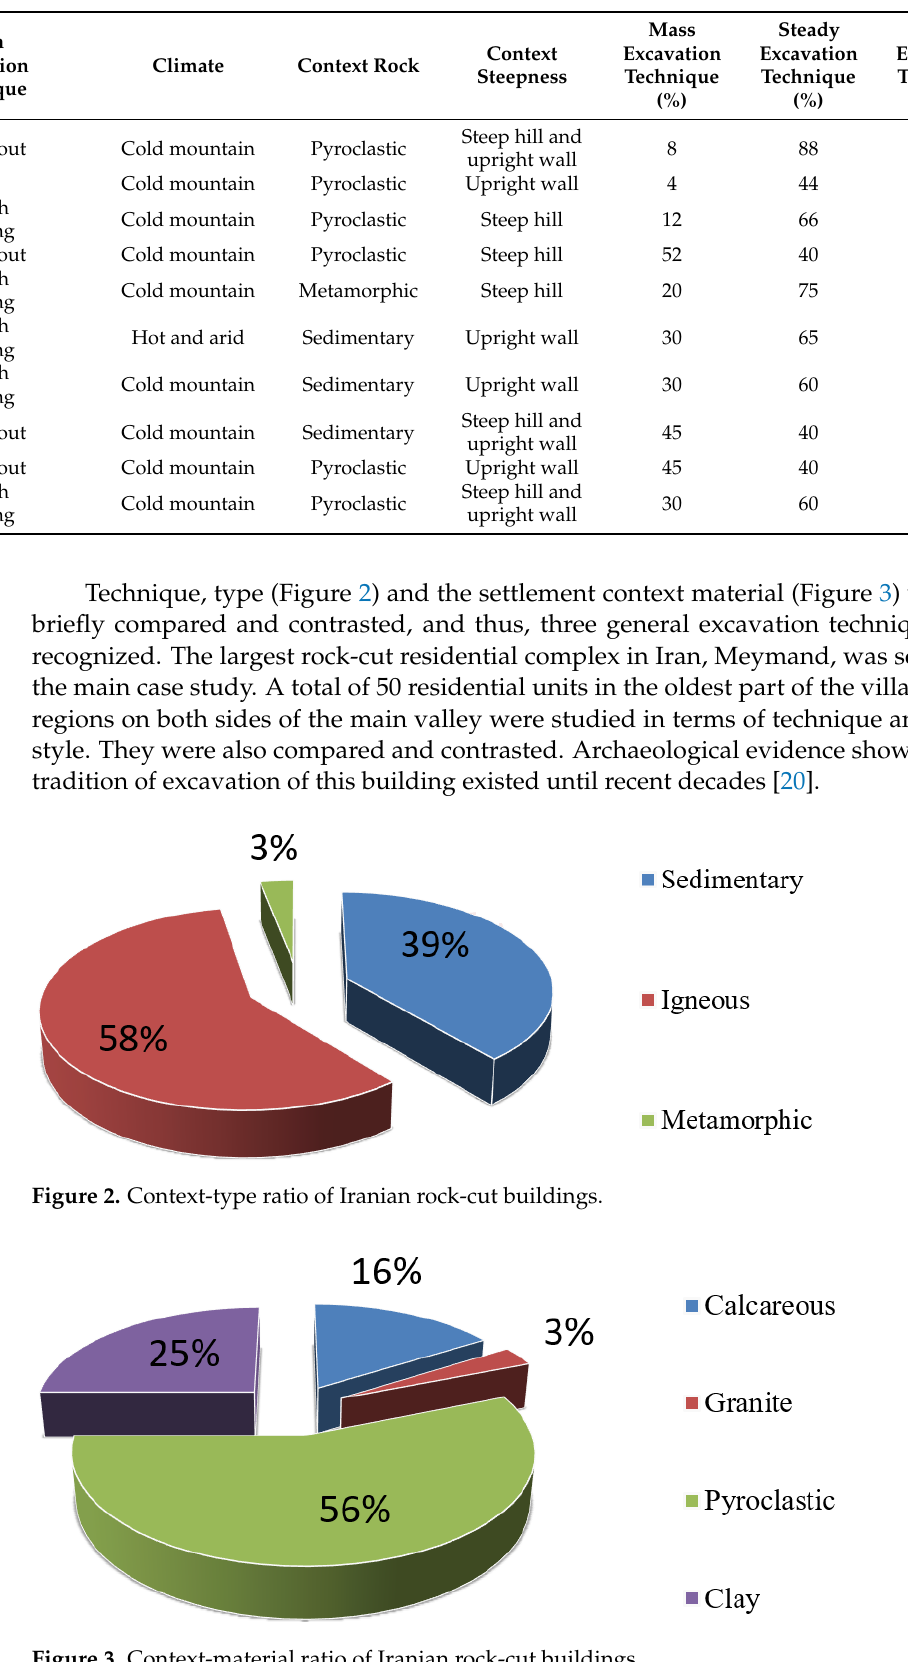
Figure 3. Context-material ratio of Iranian rock-cut buildings.